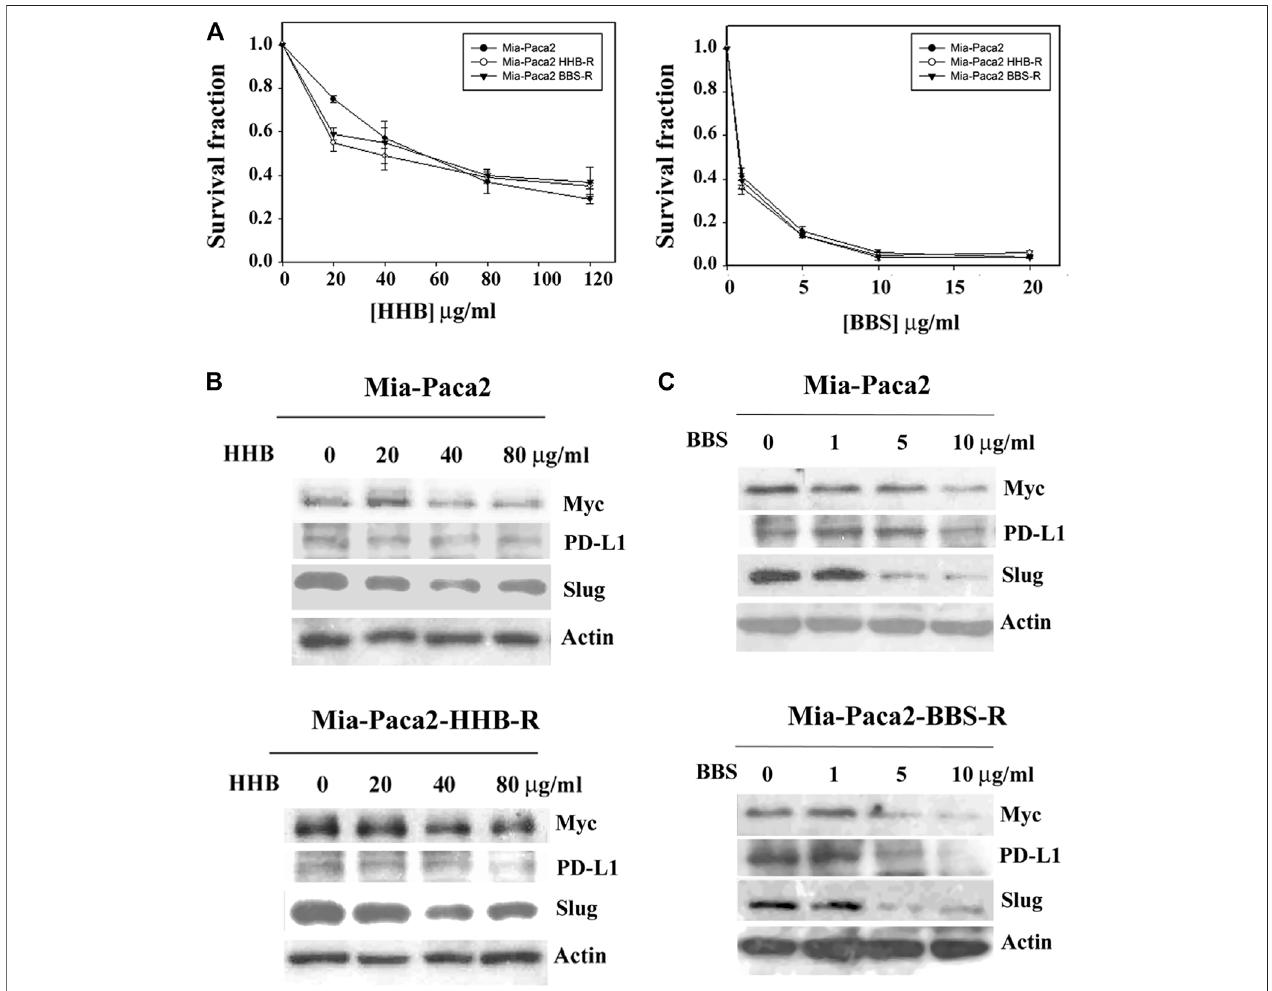
FIGURE 7 | Determination of inducible drug resistance by formula HHB and BBS treatment. (A) Mia-Paca2 cells were treated with 40 μ g/ml formula HHB or 5 μ g/ml formula BBS for 24 h and then released for another 24 h (Mia-Paca2 HHB-R cells and Mia-Paca2 BBS-R cells, respectively). Subsequently, the HHB-R/BBS-R cells were treated witha serialdoseofHHB/BBSfor 4 days.The levelofsurviving cells was determinedbyMTTassay.The survivalfractionshowsthe foldchangerelativetothe levels observedintheuntreatedcontrol.Thedataarepresentedasthemean±SD.Thecellsshowninthe fi gureweretreatedwithaserialdoseoftheformulaHHB (B) orthe formula BBS (C) for 24 h. The changes in Myc, PD-L1 and Slug expression under the indicated treatments were characterized by Western blotting analysis.